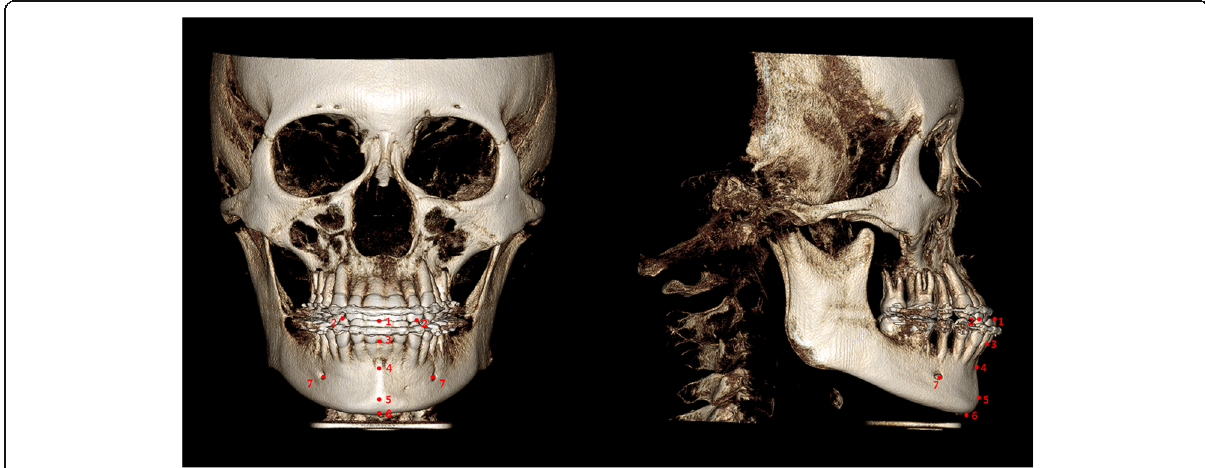
Fig. 2 Skeletal landmarks on CBCT images: 1, incision inferior (Ii); 2, lower canine (Lc) on deviated side (dev) and contralateral side (ctl); 3, infradentale (Id); 4, B point (B); 5, pogonion (Pog); 6, menton (Me); and 7, mental foramen (Mf dev/ctl). See also Table 1 for the description of 3D CBCT